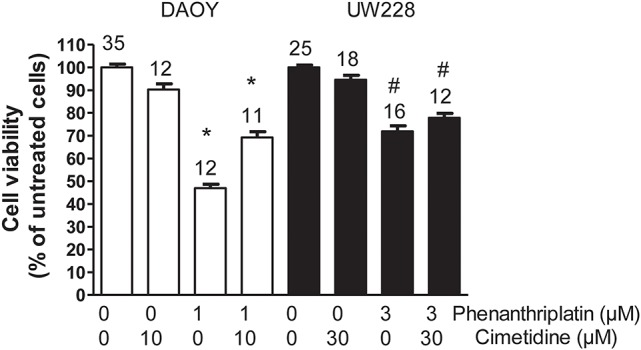
Effects of 24 h incubation of DAOY (empty columns) or UW228 (filled columns) cells with buffer (control) alone and in the presence of 1 or 3 μM phenanthriplatin alone and together with a 10-fold higher concentration of cimetidine on cell viability measured with an MTT-assay. As a further control, experiments performed only in the presence of cimetidine are also shown. Above the columns is the number of experiments. The asterisk (*) indicates a statistically significant difference compared to the other columns, #a statistically difference compared to the control experiments (ANOVA).